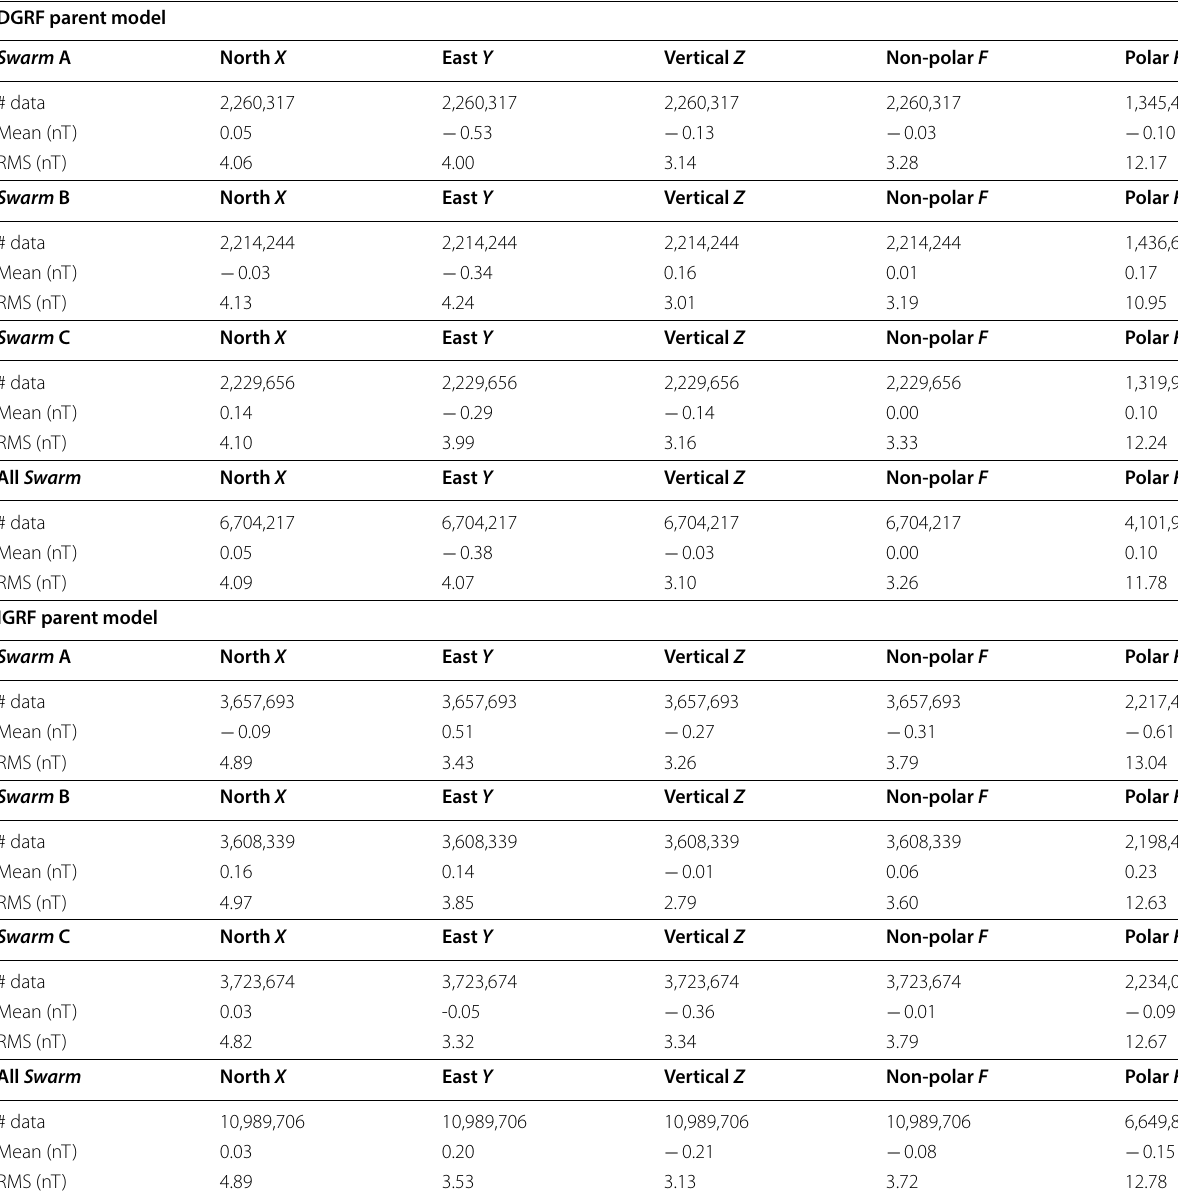
“# data” means the number of data of the considered geomagnetic element